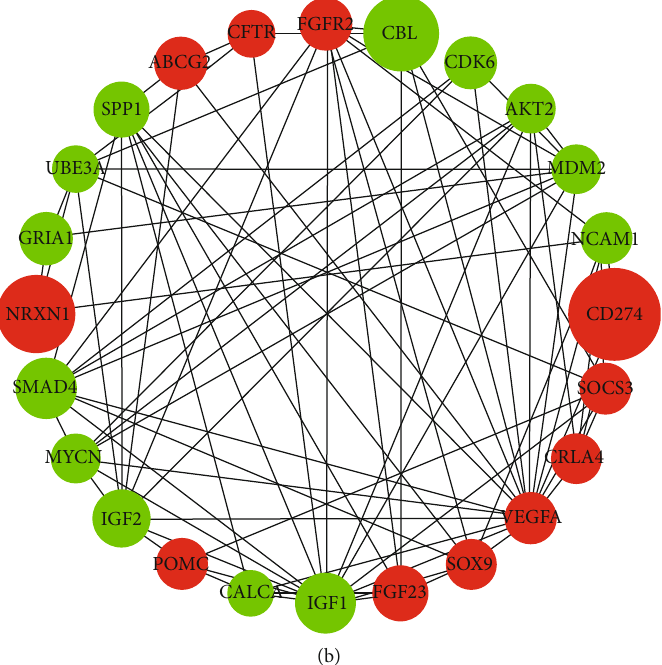
Figure 3: The PPI network of DEGs and top 24 hub genes: (a) the PPI network of DEGs; (b) the PPI network of top 24 hub genes. (The size of each node is proportional to the |log(fold change)| value. The green color indicates downregulation, and the red color indicates upregulation. The blue color indicates non-DEGs). Table 2: Di ff erentially expressed miRNAs in GSE53211. miRNA P value LogFC hsa-miR-337-5p 0.000244 2.24308 hsa-miR-127-5p